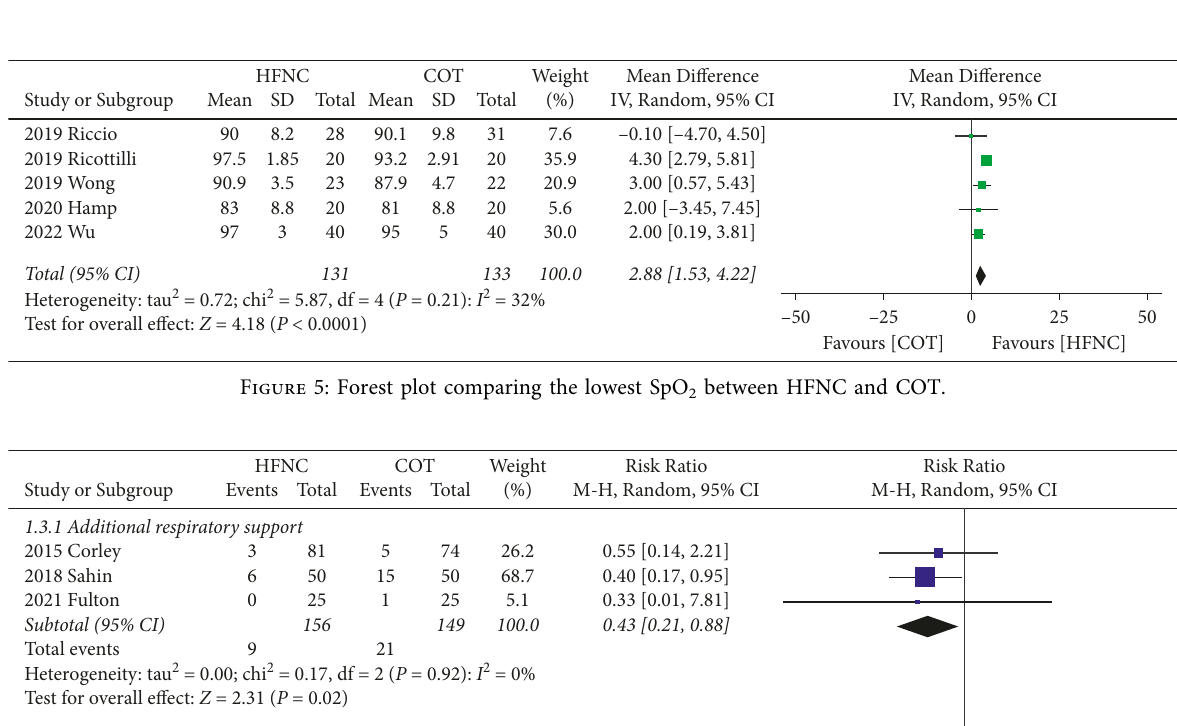
Figure 4: Forest plot comparing the incidence of hypoxemia between HFNC and COT.